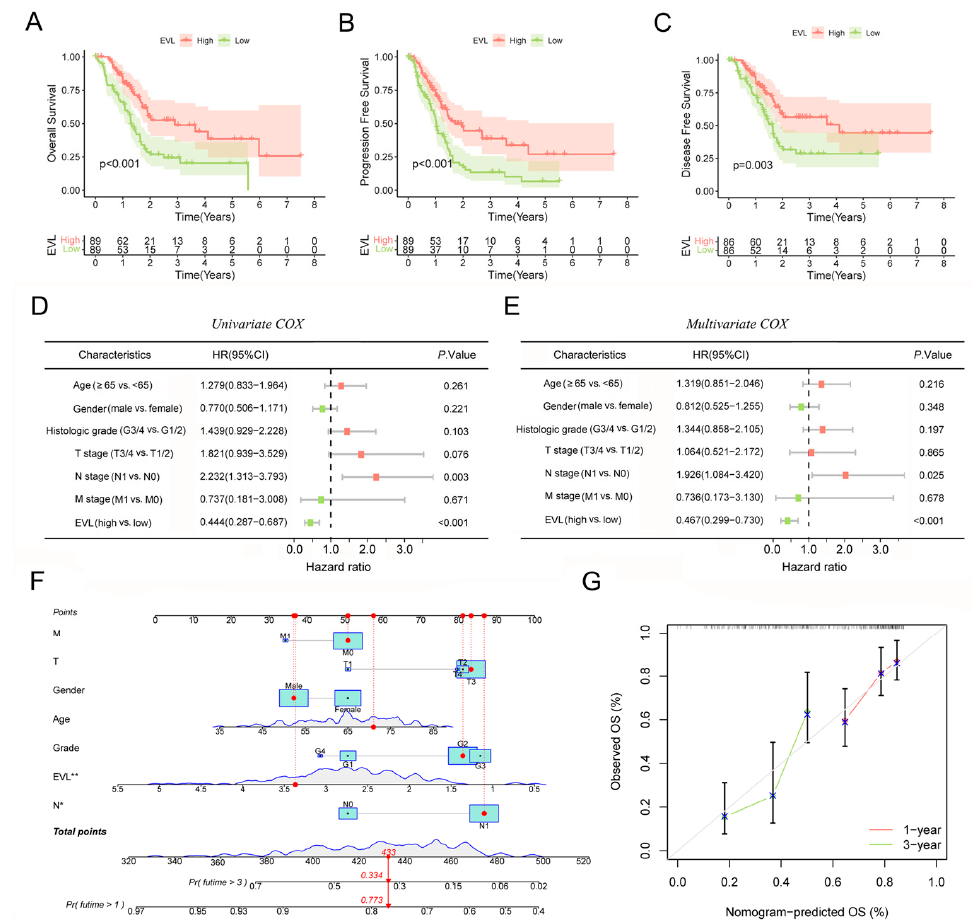
Figure 6. EVL indicates a good prognosis for pancreatic cancer patients. ( A – C ) Kaplan–Meier survival curves of overall survival time, progression-free survival time and disease-specific survival time; ( D , E ) Univariate and multivariate Cox analysis of EVL and clinical characteristics. ( F , G ) The nomogram model and calibration plot of EVL and clinical characteristics. EVL, Ena-VASP-like. * p < 0.05; ** p < 0.01.